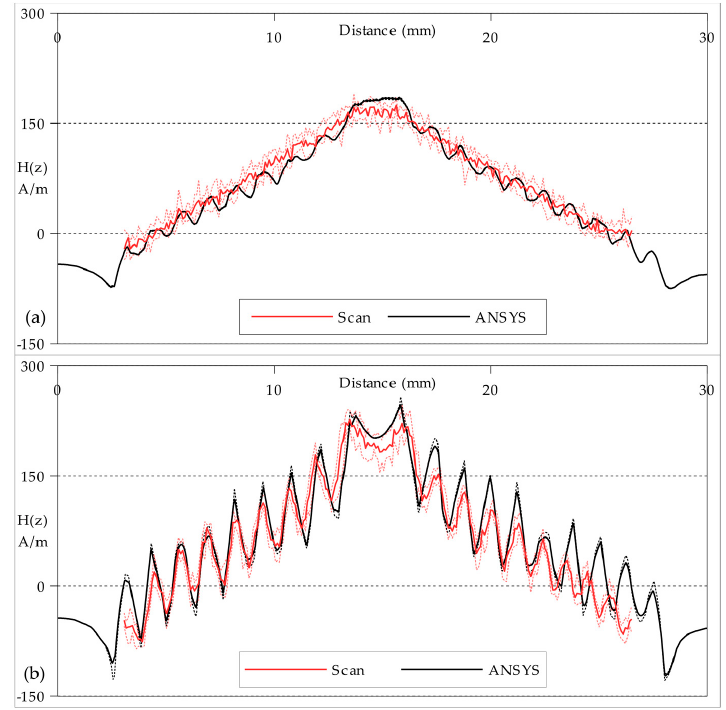
Figure 8. H ( z ) amplitude plots of the Circular planar coil along the path indicated by red single-chevrons in Figure 6: ( a ) at a scan height of 0.50 mm ± 0.01 mm; ( b ) at a scan height of 0.15 mm ± 0.01 mm. The ± errors are indicated by dashed lines above and below for both the Scan and ANSYS plots. The distance scale is the distance (mm) along the path from the left edge of the planar coil.